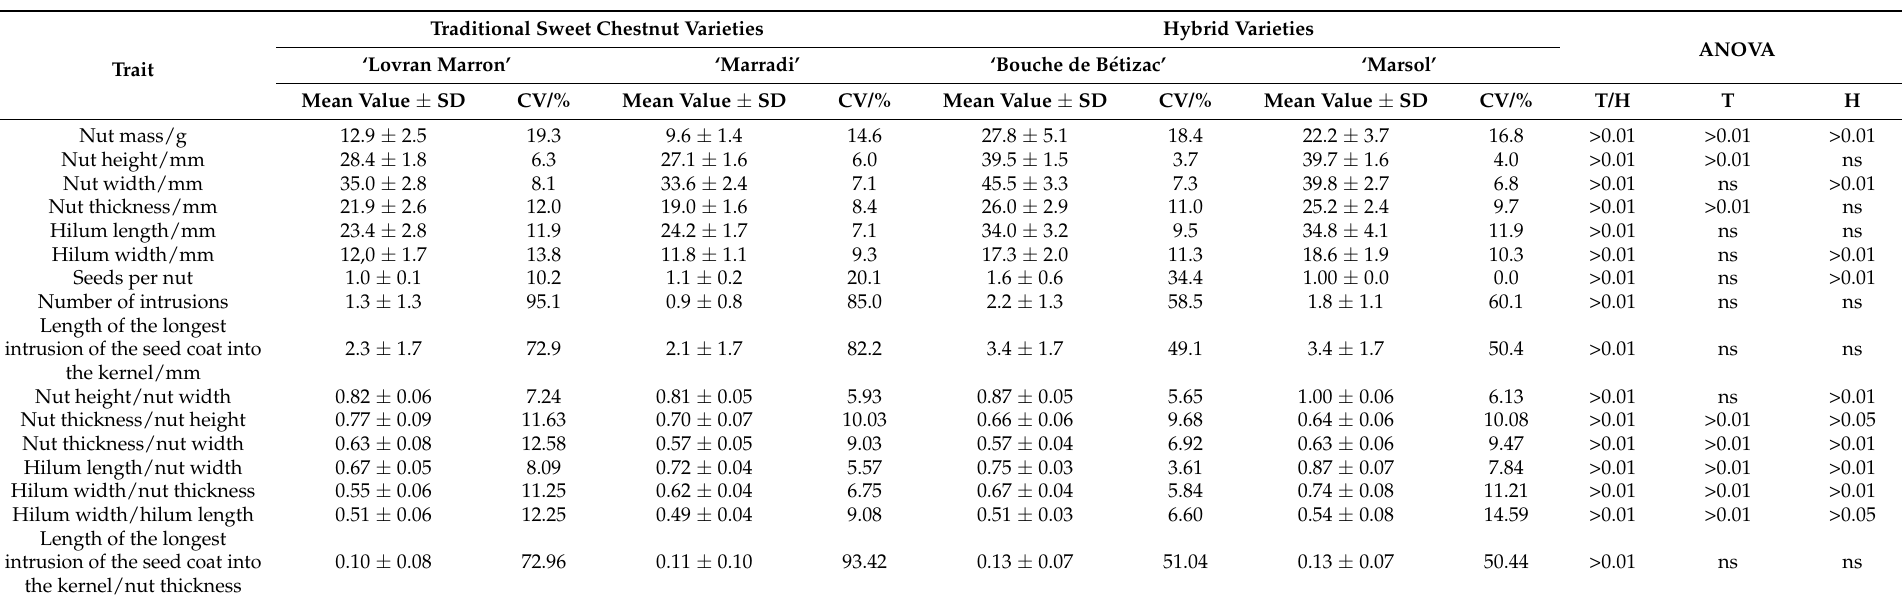
Table 1. Morphometric characteristics—descriptive statistical parameters and levels of